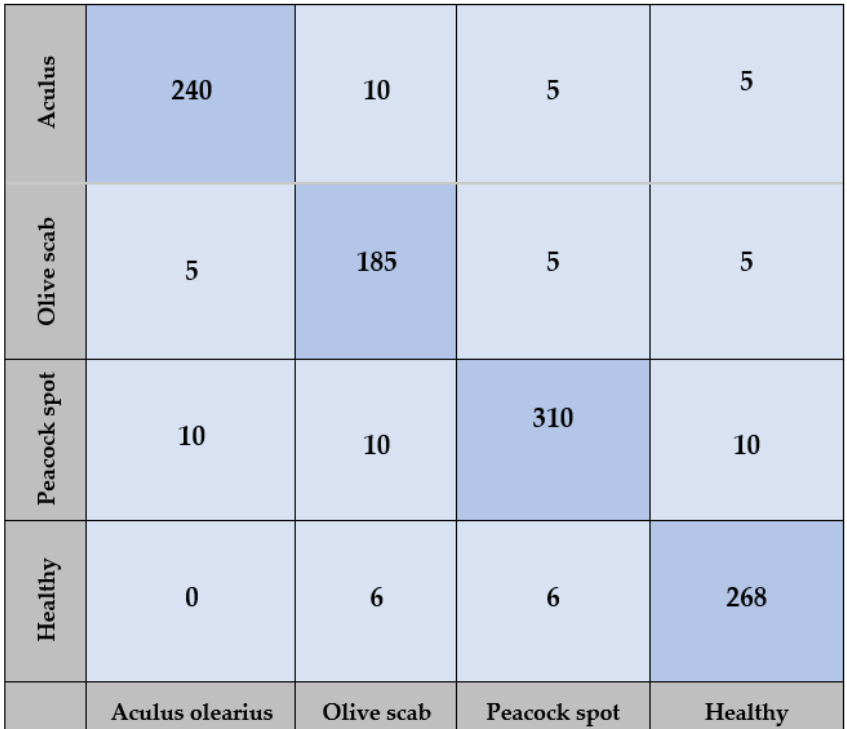
Table 3. Average classification results of the original dataset.